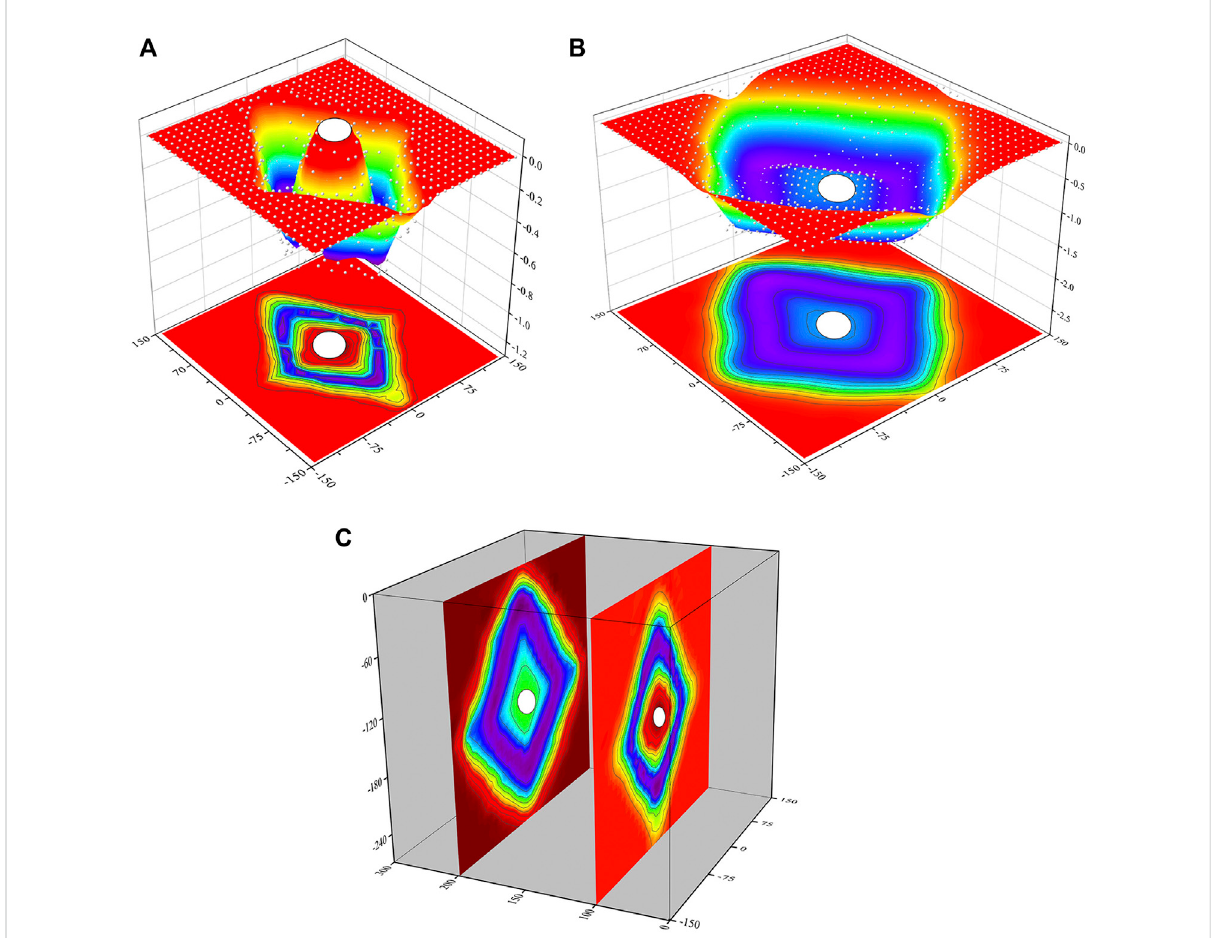
FIGURE 13 Displacementdeformationmodelofexcavation face: (A) Displacementdeformationmodelofexcavationface1, (B) Displacementdeformation model of excavation face 2, (C) superimposed displacement deformation